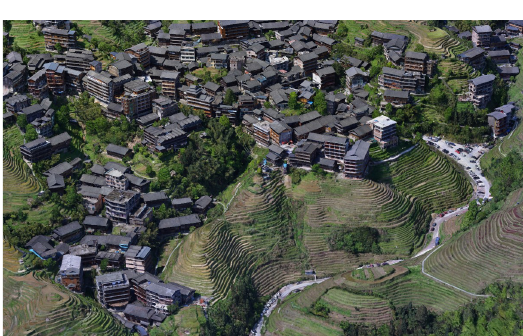
Figure 3. The schematic diagram of 3D model results